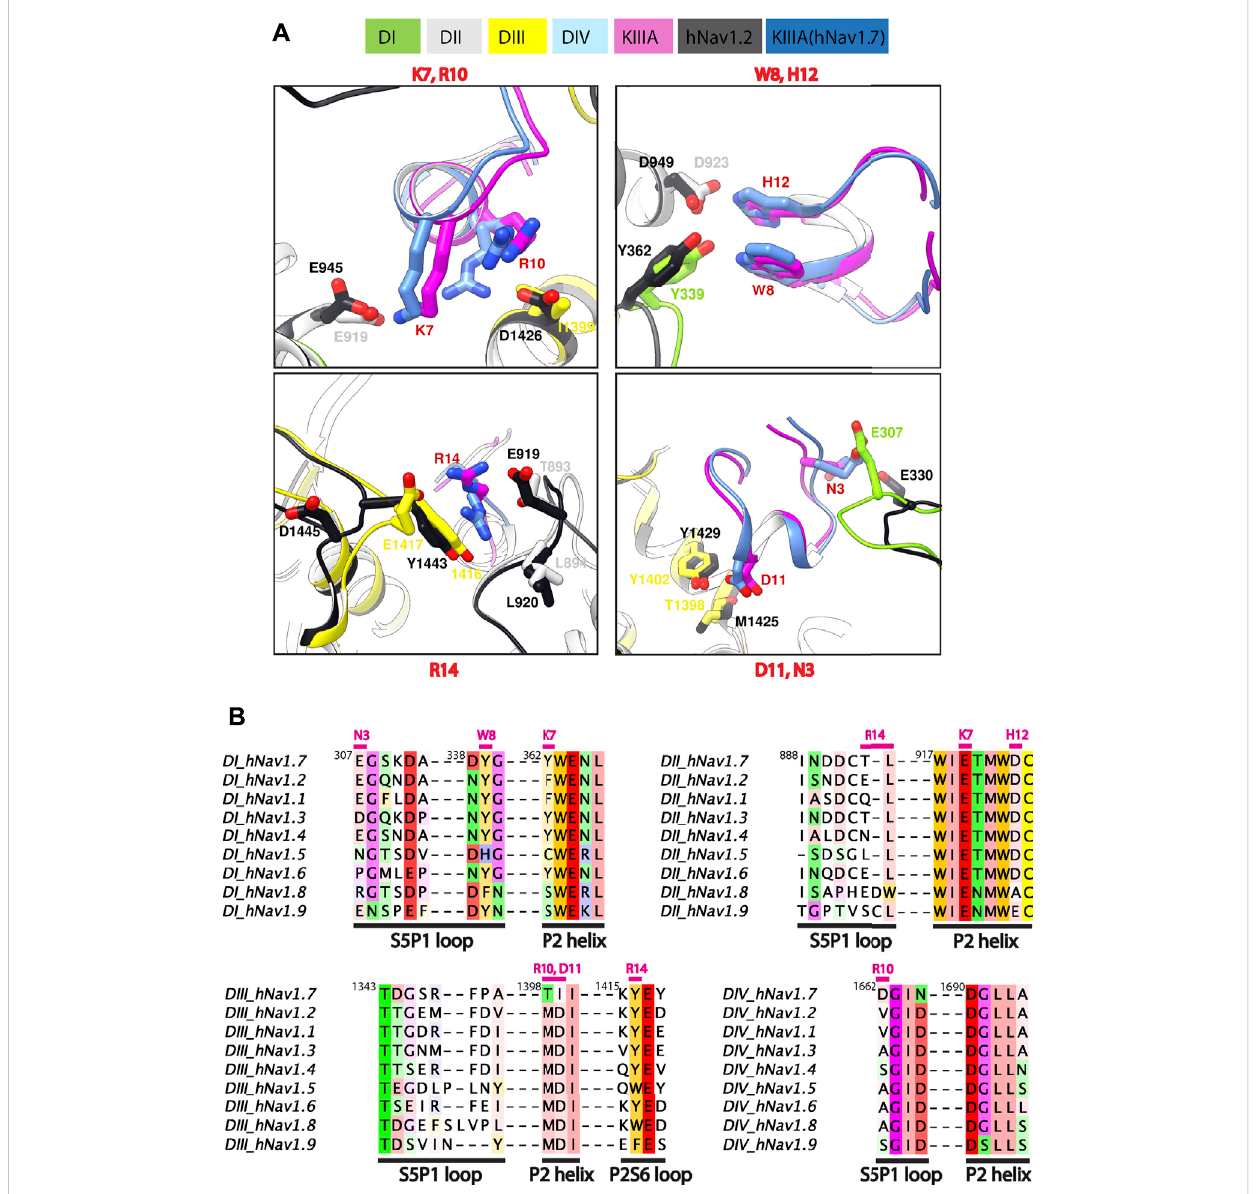
FIGURE 4 Marked difference for KIIIA binding speci fi city among Na V channel isoforms. (A) Comparisons of key residue interactions on the KIIIA — hNa V 1.7 model and the KIIIA — hNa V 1.2 structure. Domains and residue labels are depicted according to color keys. (B) Sequence alignment of the different Na V subtypes at the interaction site with KIIIA. Different regions are labeled. Key interacting residues of KIIIA are labeled and colored in magenta at positions of corresponding interactions in channel residues. Superscripts show sequence number of hNa V